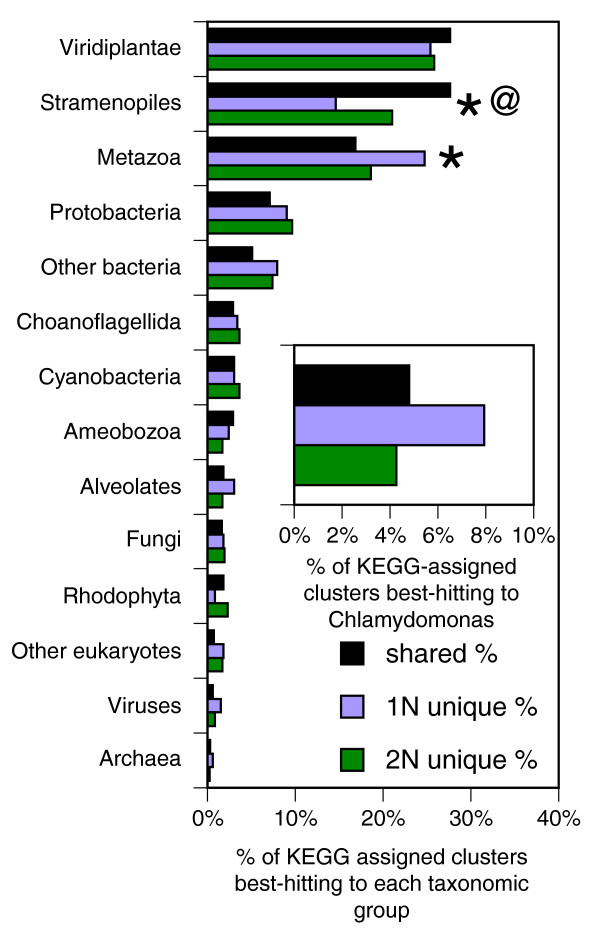
The taxonomic distribution of homology. Shown are the percentages of clusters with KEGG homologs that have the 'best hit' in each taxonomic group. Indicated are cases where the proportion of clusters best hitting to the taxonomic group differs between 1N-unique and 2N-unique (asterisks) or between 1N-unique and shared clusters (at symbol (@)), tested as above. The inset shows the proportion of all assigned clusters that are accounted for by best-hits to Chlamydomonas reinhardtii (a subset of those which are best-hits to Viridiplantae). The differences between 1N-unique and 2N-unique, and between 1N-unique and shared clusters were significant (P < 0.002).